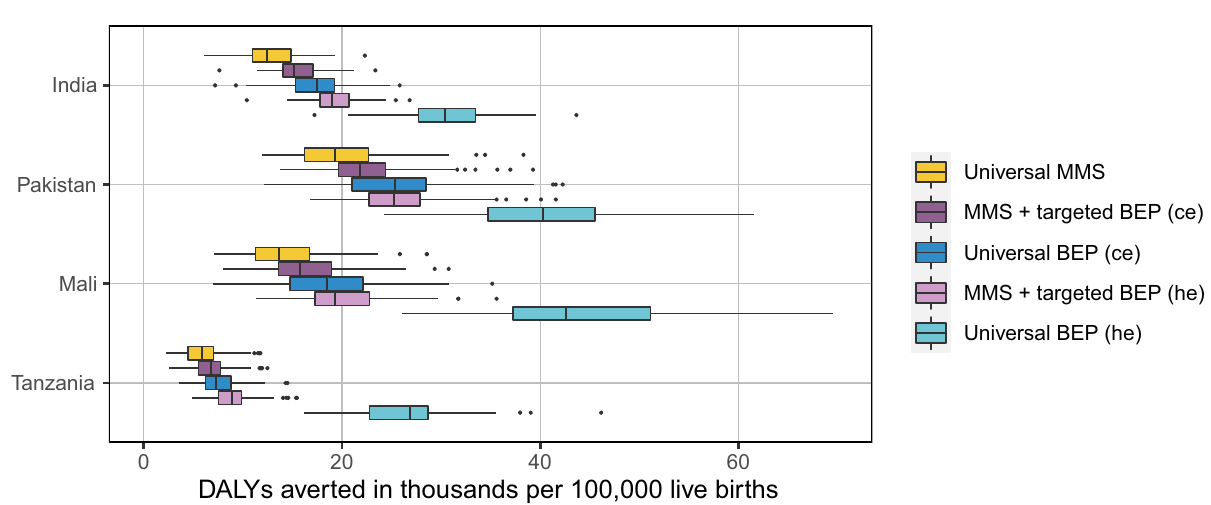
Fig 4. DALYs averted in thousands relative to the baseline scenario for each simulated supplementation intervention scenario among children under 2 per 100,000 live births by location. The width of the colored boxes represents the interquartile range (25th to 75th percentiles); the solid line in the box represents the median (50th percentile); the whiskers on either end of the box represent the minimum and maximum values; and the points represent outlier values. BEP, balanced energy protein; ce, scenarios with current evidence effects for BEP; DALY, disability-adjusted life year; he, scenarios with hypothesized effects for BEP; MMS, multiple micronutrient supplementation.